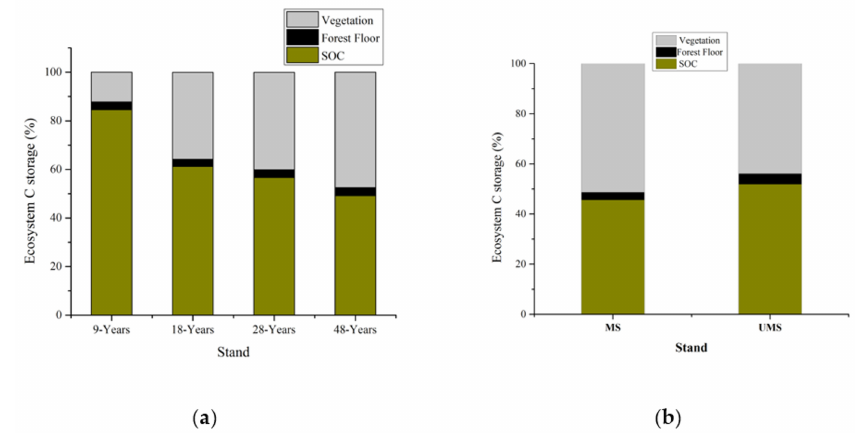
Figure 6. Ecosystem carbon allocation by stand age and two management treatments in P. massoniana plantations ( a ) represents the carbon storage in age sequence while ( b ) demonstrates the carbon storage in the two management